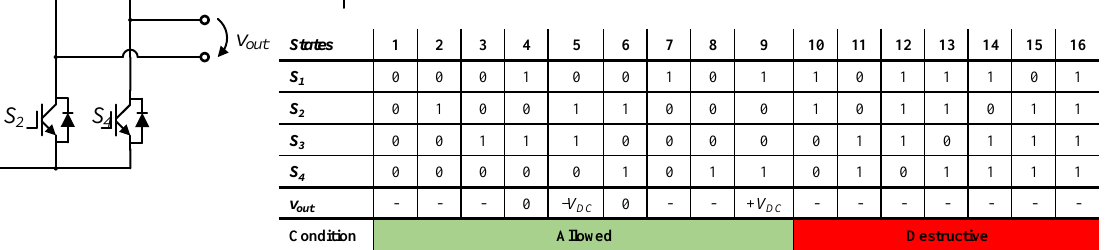
Figure 5. Full-bridge topology and operation principle.